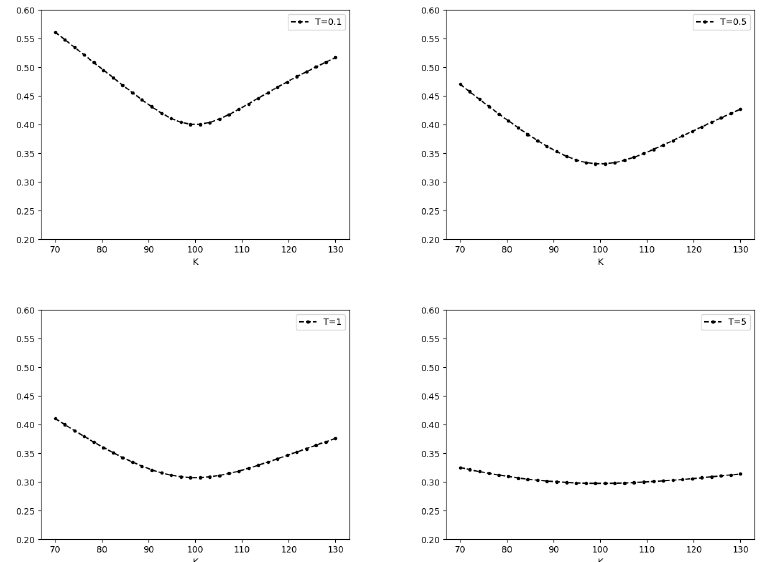
= 0.05, θ = 0.9, k = 3, ν = 0.8, ρ = 0 and 0 0